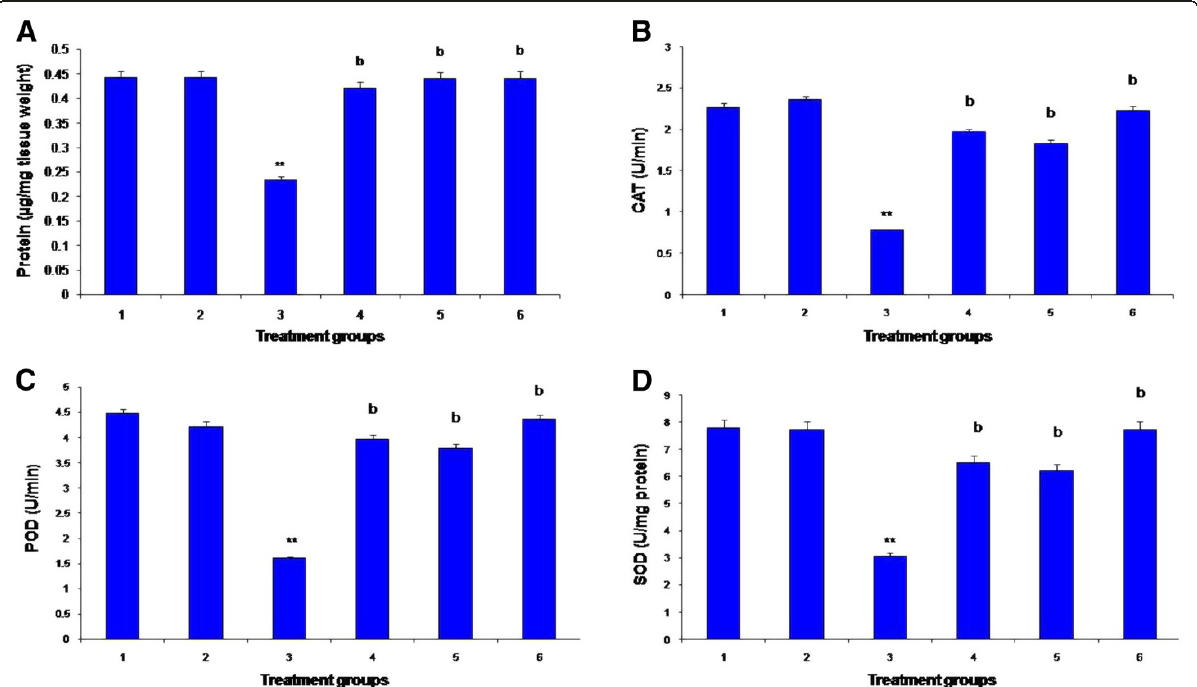
Figure 1 (A-D) Effect of LME treatments on tissue protein (A), antioxidant enzymes; catalase (CAT) (B), peroxidase (POD) (C) superoxide dismutase (SOD) (D) in lungs of various groups in rat. I: control; II: vehicle (olive oil+DMSO); III: CCl 4 3 ml/kg; IV: CCl 4 +rutin 50 mg/kg; V: CCl 4 +LME 100 mg/kg; VI: CCl 4 +LME 200 mg/kg; ** (P<0.01) show significance from the control group. b (P<0.01) show significance from the CCl 4 group. Mean±SE (n=06